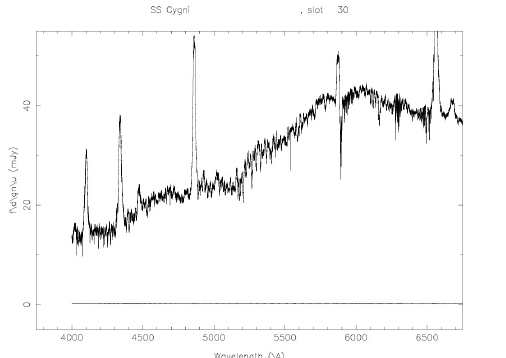
Figure 1: A portion of the average of 29 spectra of SS Cygni taken with the echelle spectrograph on the 3.5-m APO on 20/21 September 2012. In addition to strong emission lines, there are many absorption lines suitable for Roche tomography of the